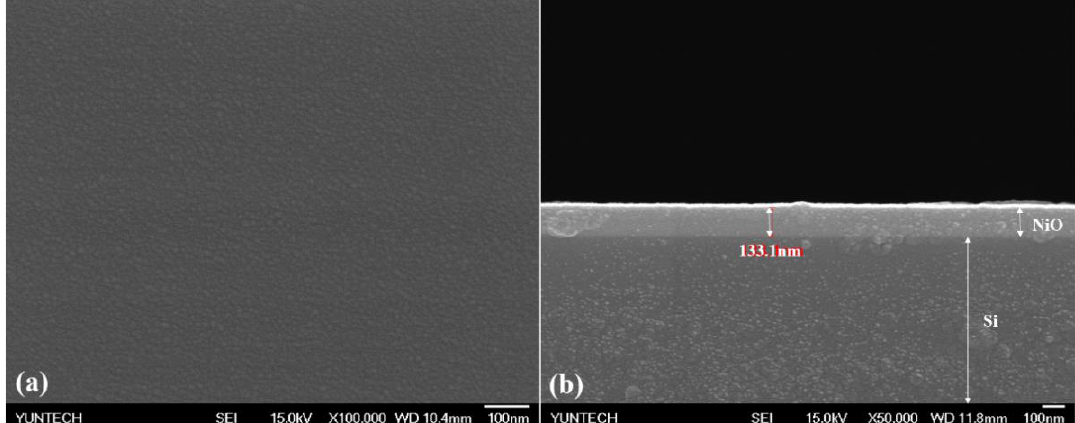
Figure 2. FE-SEM ( a ) top view and ( b ) cross-section images of the NiO film on the silicon substrate.